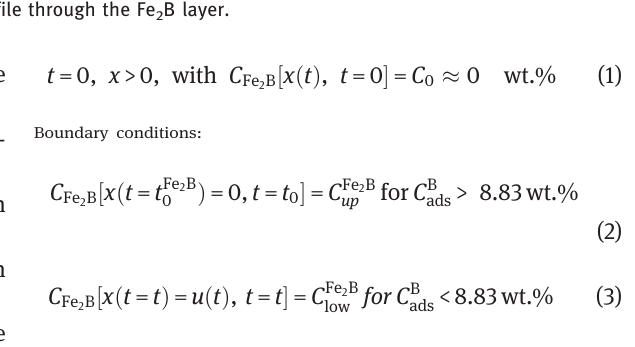
Figure 1: Schematic representation of the boron-concentration profile through the Fe 2 B